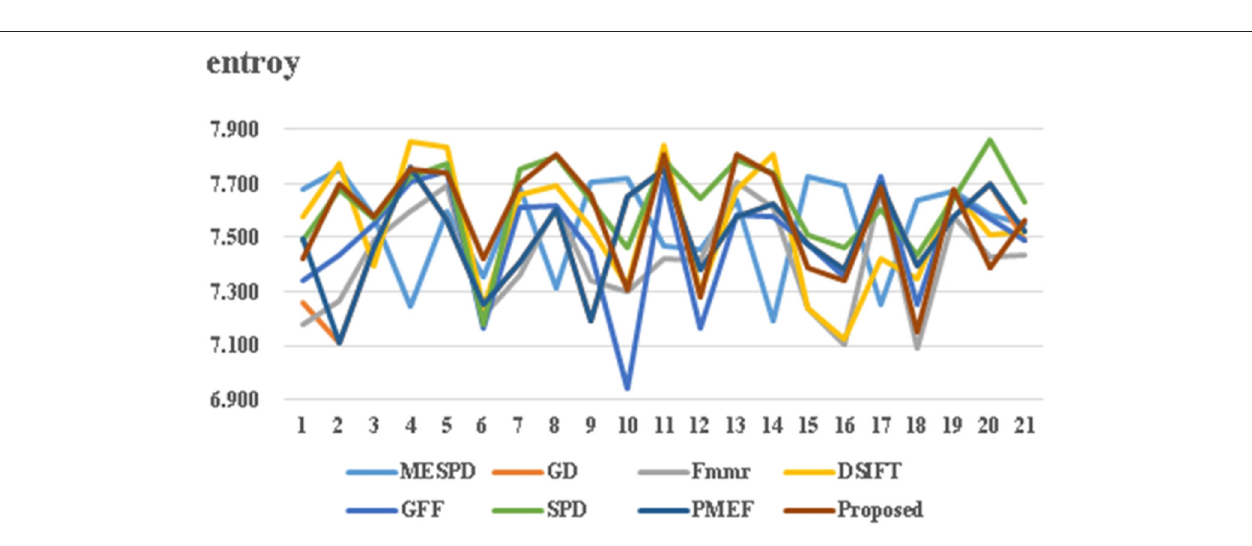
FIGURE 6 | Information entropy comparison of seven fusion